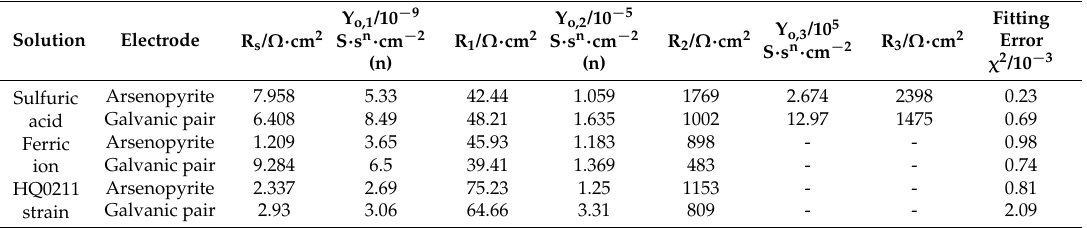
Table 3. Fitting data and fitting errors of the investigated electrochemical impedance spectroscopy (EIS) data.